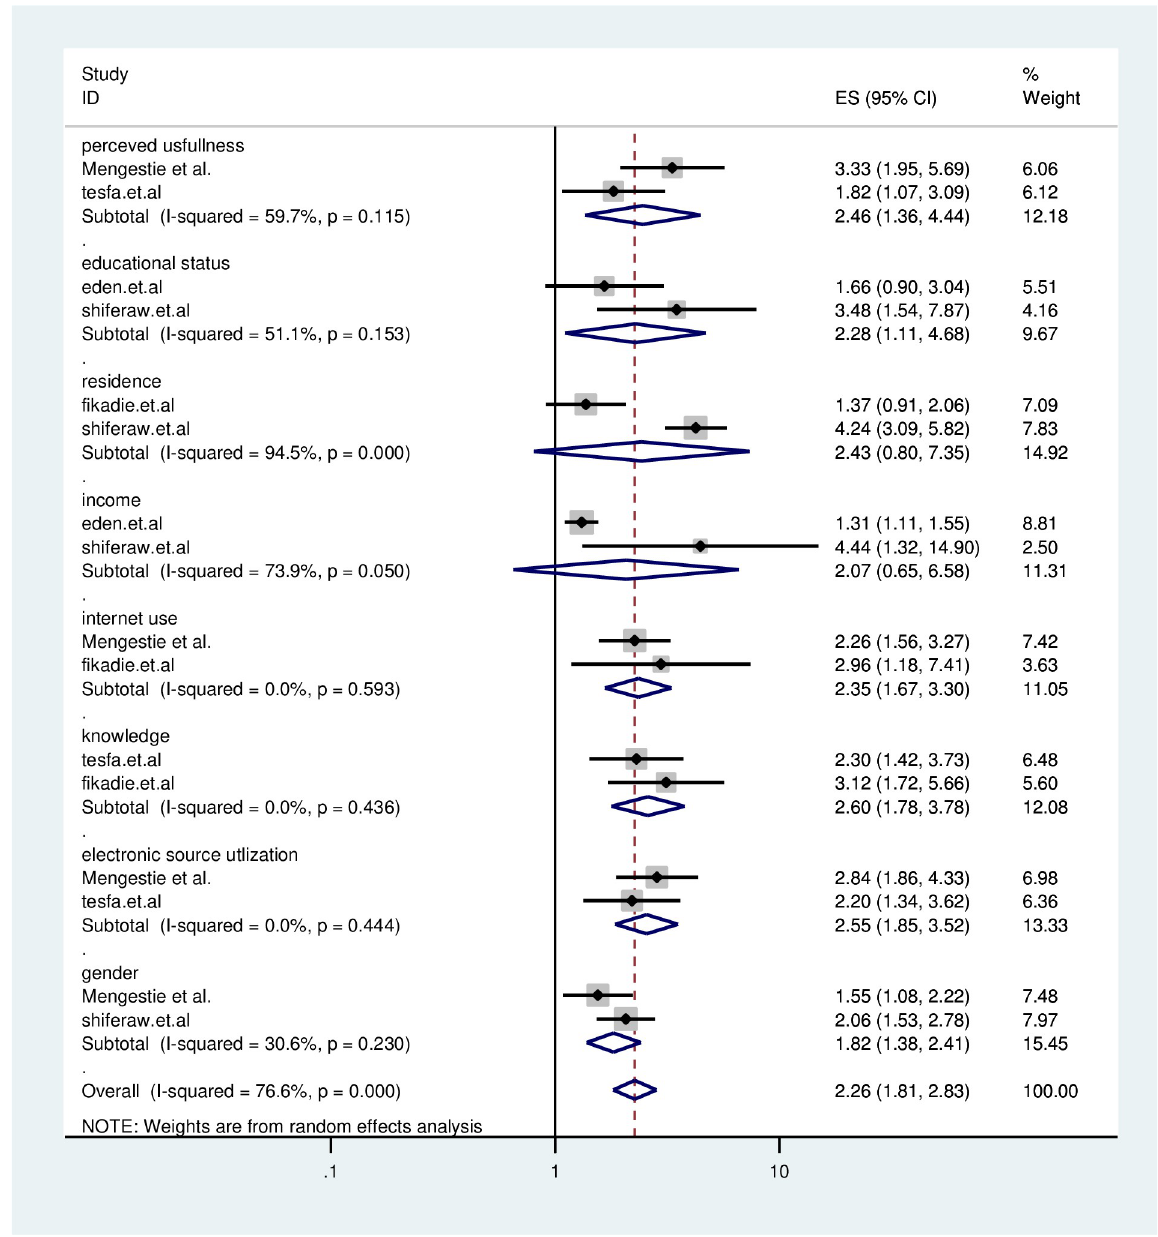
Fig 4. Graphical representation of factors associated with eHealth literacy in Ethiopia 2022.